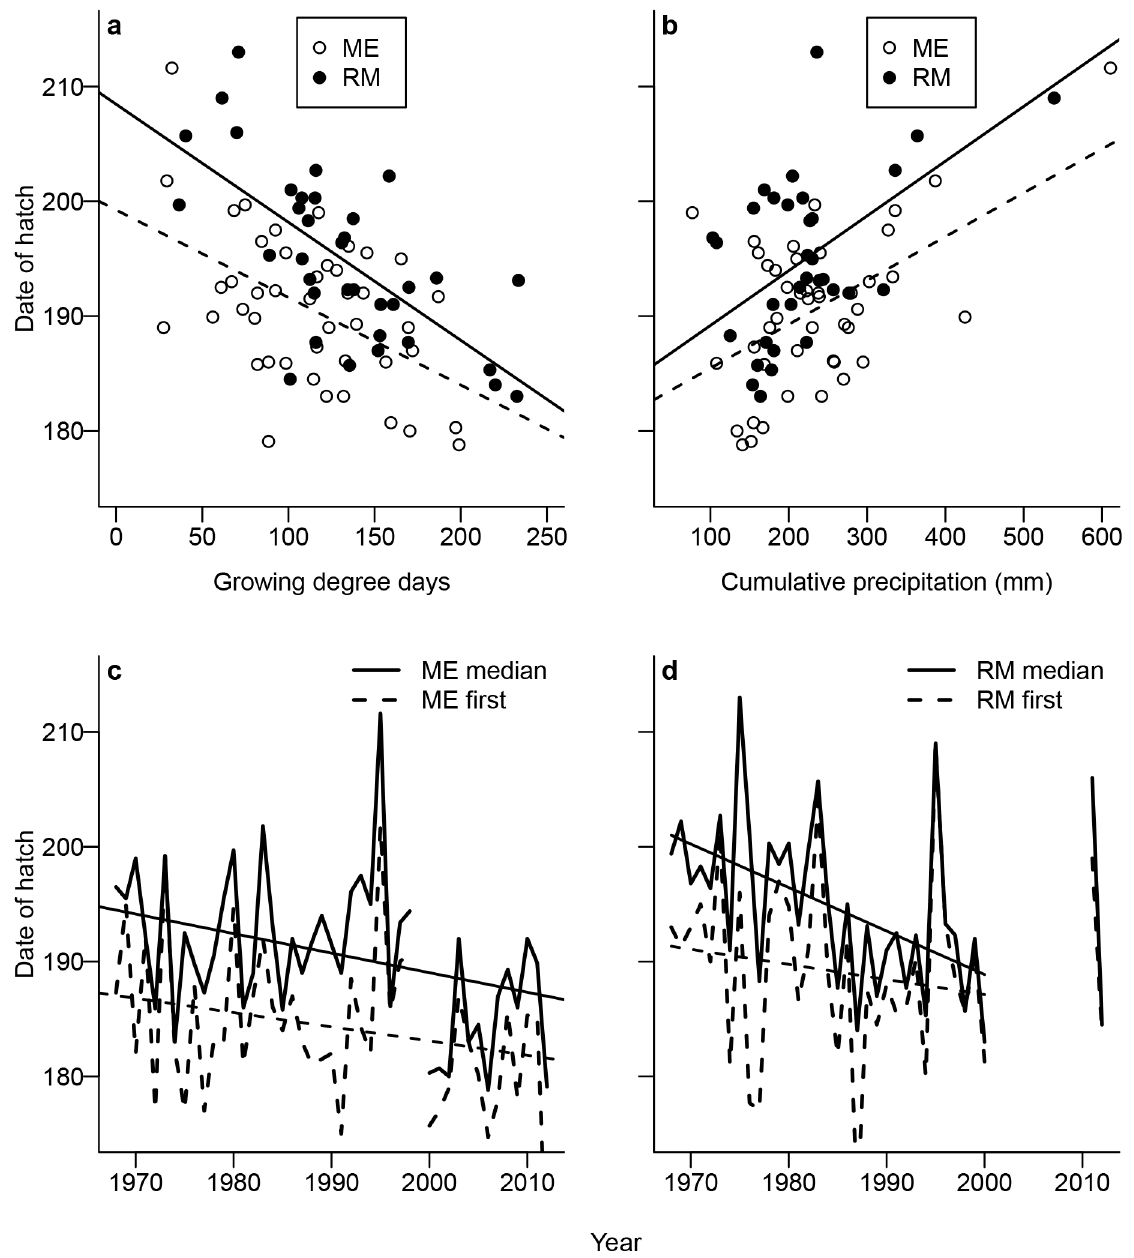
Fig 1. Breeding phenology drivers and temporal trends of white-tailed ptarmigan at Mt. Evans (ME; 1968 – 2012) and Trail Ridge in Rocky Mountain National Park (RM; 1968 – 2000, and 2011 – 2012) in Colorado, USA. Relationships between median date of hatch and number of spring growing degree days (a) and cumulative spring precipitation (b) at ME (open circles, dashed lines) and RM (closed circles, solid lines) are presented along with temporal trends of the first (dashed lines) and median (solid lines) date of hatch at ME (c) and RM